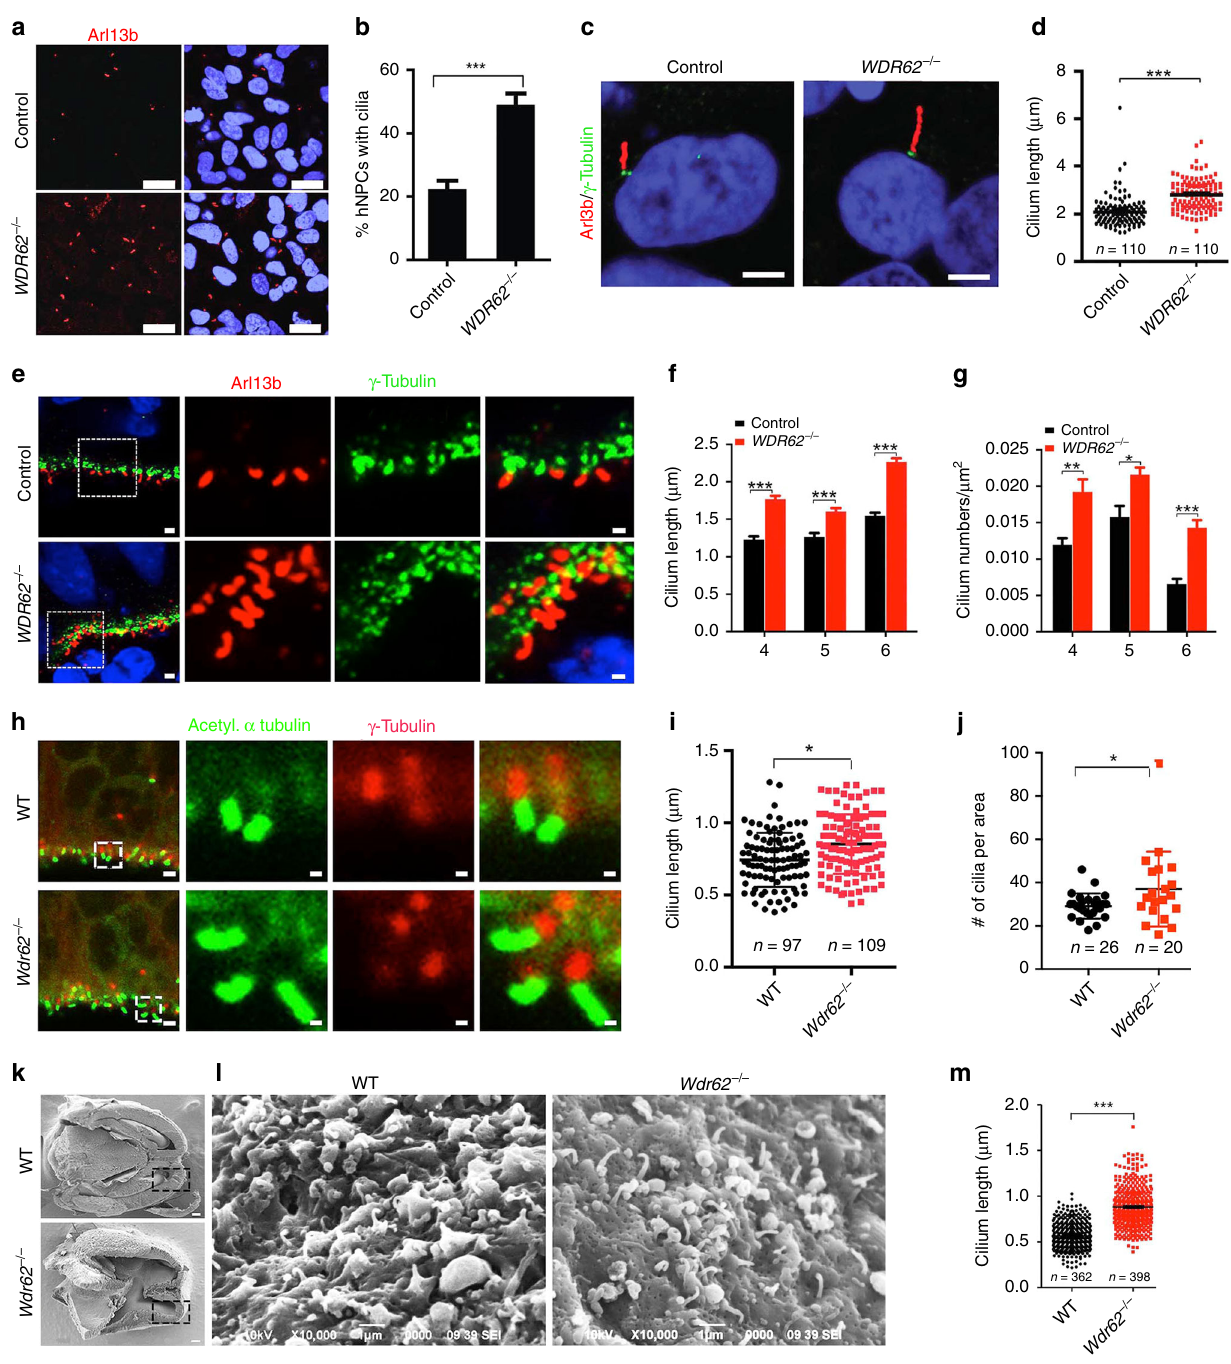
Fig. 4 Increased cilium length in mutant NPCs in cerebral organoids and mice. a Confocal imaging of 2D human NPCs stained with antibodies against Arl13b (red). Hoechst stains nuclei (blue). Scale bars: 50 μ m. b Quanti fi cation of the percentage of human NPCs with cilium. Error bars represent SEM of three independent experiments from control ( n = 168) and mutant ( n = 186) NPCs; *** P < 0.001 (Student ’ s t -test). c Confocal imaging of 2D human NPCs stained with antibodies against Arl13b (red) and γ -tubulin (green). Hoechst stains nuclei (blue). Scale bars: 2.5 μ m. d Quanti fi cation of cilium length in NPCs. Error bars represent SEM of three independent experiments from control ( n = 110) and mutant ( n = 110) NPCs with cilia; *** P < 0.001 (Student ’ s t -test). e Confocal imaging of sections from week 6 organoids stained with antibodies against Arl13b (red) and γ -tubulin (green). Hoechst stains nuclei. Scale bars: 1 μ m. f , g Quanti fi cation of cilium length or numbers per μ m 2 in organoid sections. Error bars represent SEM of three independent experiments; * P < 0.05, ** P < 0.01, *** P < 0.001 (Student ’ s t -test). h Confocal imaging of coronal sections of E12.5 cerebral cortex stained with antibodies against acetylated α -tubulin (green) and γ -tubulin (red). Scale bars: leftmost, 2 μ m; right, 0.35 μ m. i , j Quanti fi cation of cilium length and numbers per area (598.148 μ m 2 ) in E10.5 developing cortex. Error bars represent SEM of three independent experiments; * P < 0.05 (Student ’ s t -test). k , l Scanning electron microscopy (SEM) analysis of cilium in E12.5 cortex. Panels in l are enlargement of boxed areas in k . Scale bars: 100 μ m in k , and 1 μ m in l . m Quanti fi cation of cilium length from WT ( n = 362) and mutant ( n = 398) SEM results in